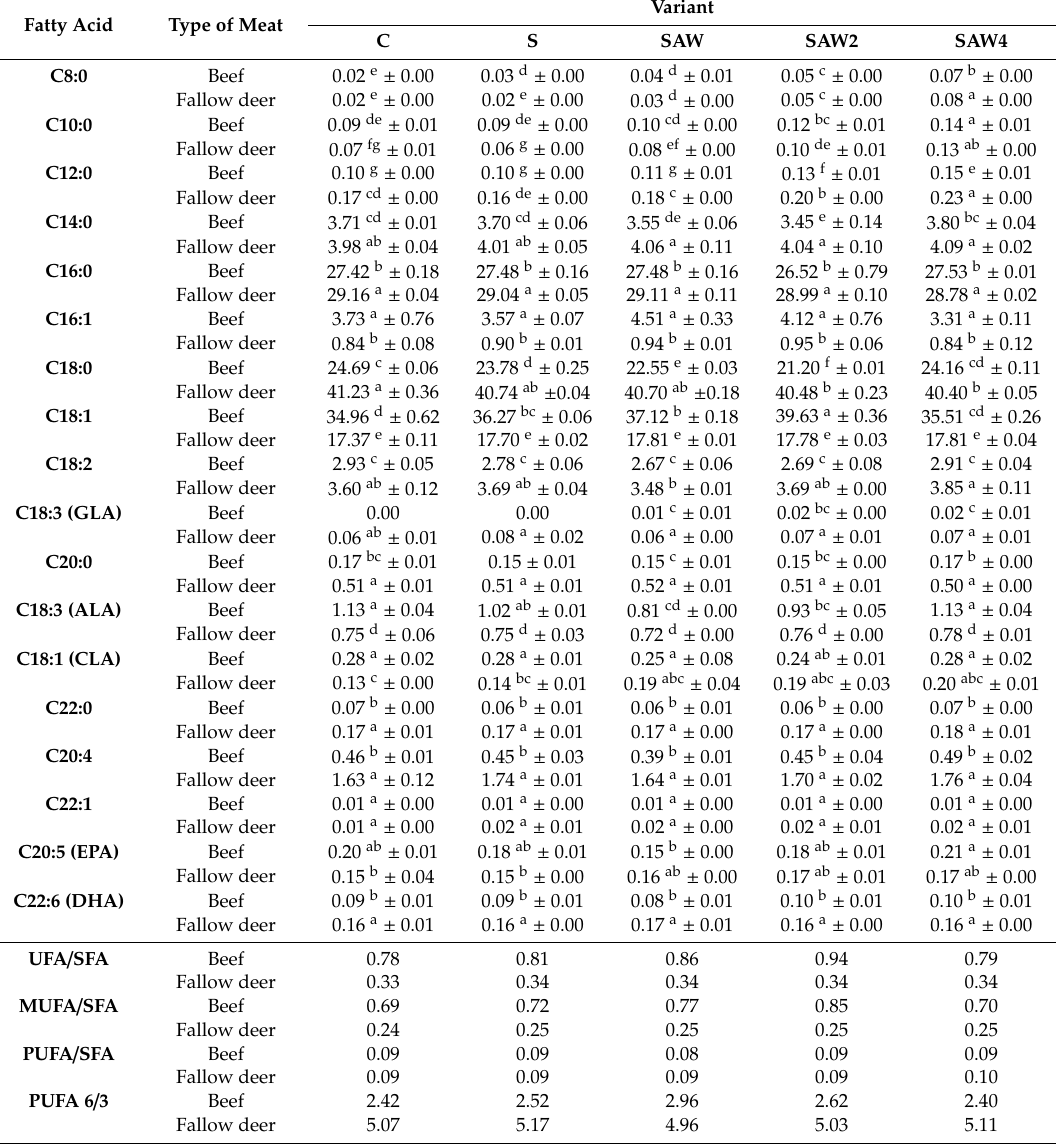
Table 8. Fatty acid profile (%) of sausages made from beef and fallow